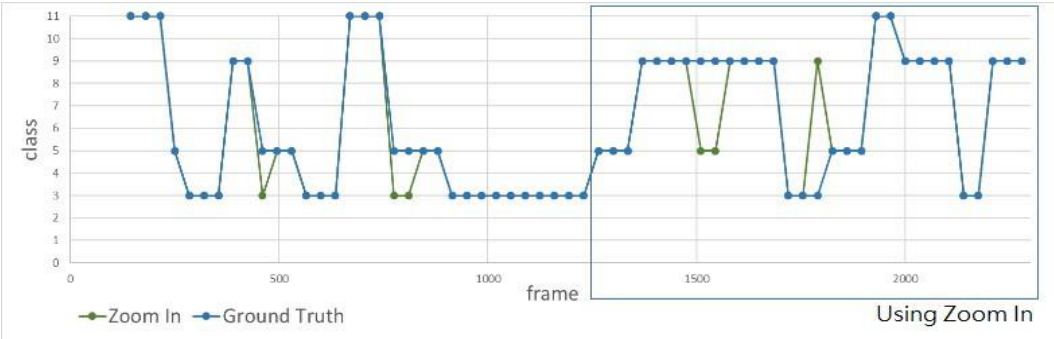
Figure 11. Recognition result using the zoom-in function (green line), where the blur rectangle indicates the individual is located far from the camera.